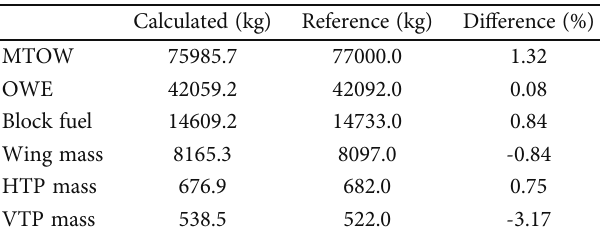
Table 4: Calculated component mass as compared to reference